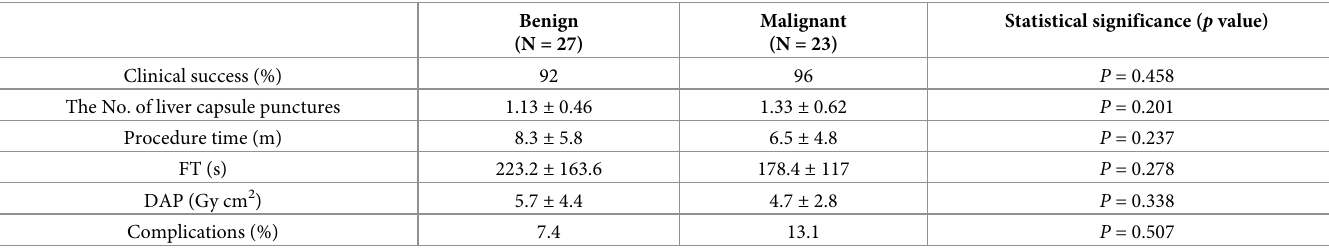
Table 5. Procedural data reported for benign and malignant biliary stenosis/obstruction.